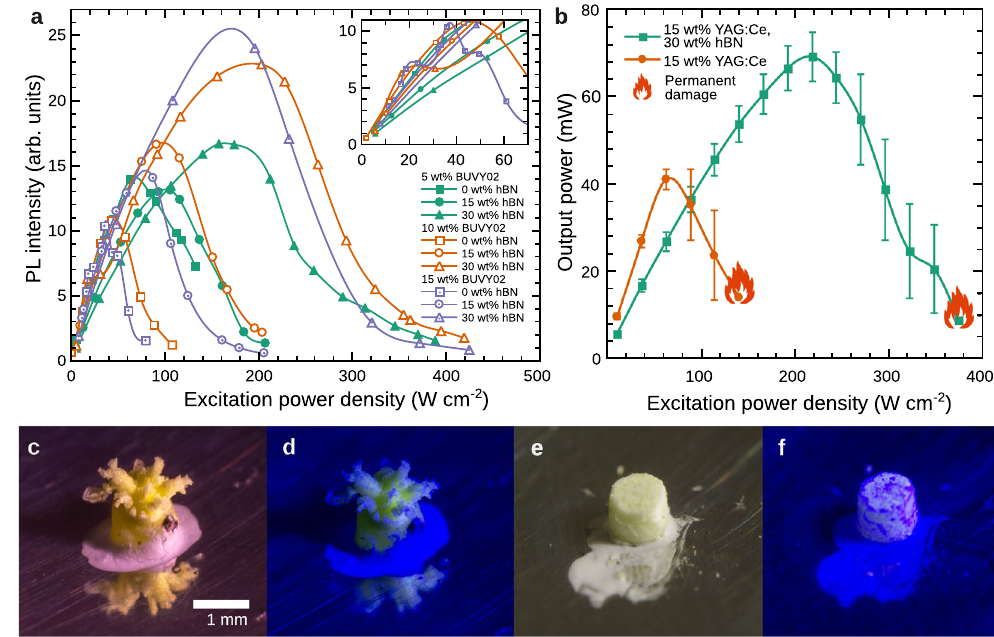
Figure 6. Impact of high power density LD excitation light (peak 442 nm, focus diameter 0.5 mm) on silicone- phosphor converters. ( a ) The PL intensity dependence of different composition 2 × 2 mm cylinder BUVY02 phosphor-silicone converters on the excitation power density. The inset shows the enlarged area between 0 2 and 70 W cm − excitation power density. ( b ) The spectral power emitted by a 1 × 1 mm cylinder silicone light converter containing only 15 wt% of YAG:Ce phosphor (orange circles) and with additional 30 wt% of hBN powder (green squares) as a function of excitation power density. ( c , d ) The physical damage of the silicone light converter containing 15 wt% YAG:Ce phosphor caused by the LD excitation of 160 mW optical power 2 (88 W cm − ) under white (conventional fluorescent lamp) and blue 447 nm LED light respectively. ( e , f ) An analogous converter additionally containing 30 wt% of hBN particles affected by 400 mW LD excitation 2 (218 W cm − ). In the latter case no physical damage is